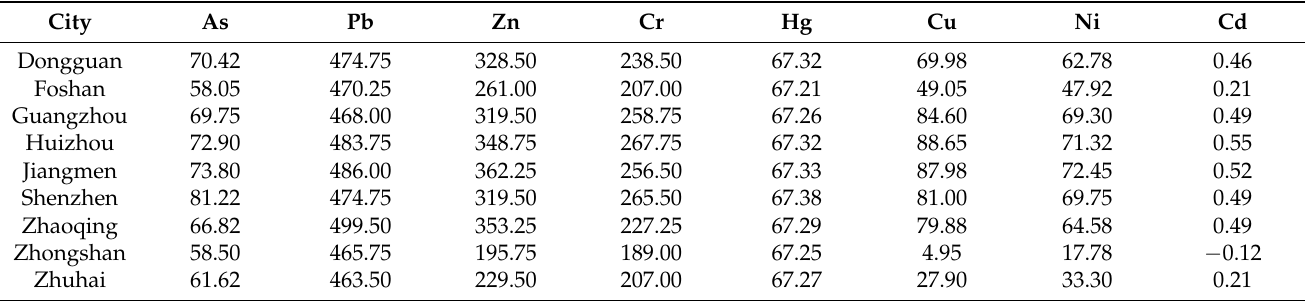
Table 3. Static capacity in the soils of the cities in the Pearl River Basin (kg/hm 2